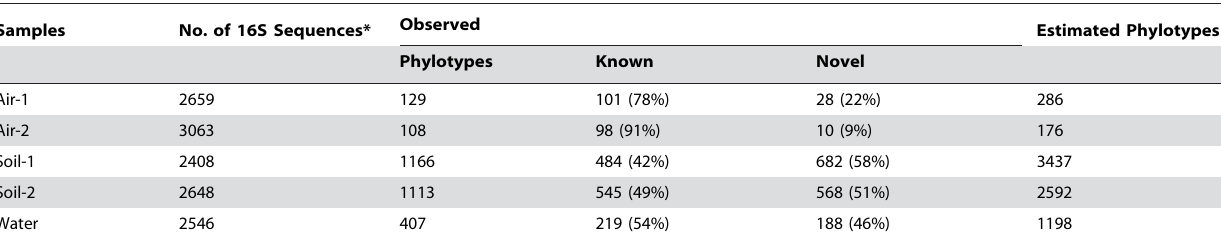
Table 1. 16S rDNA